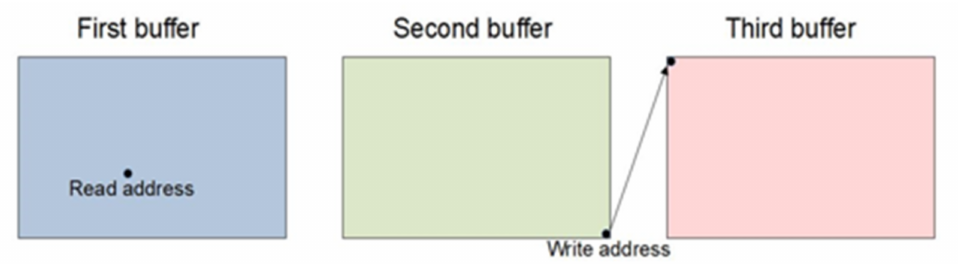
Figure 5. Triple buffering logic: buffer change for write process.